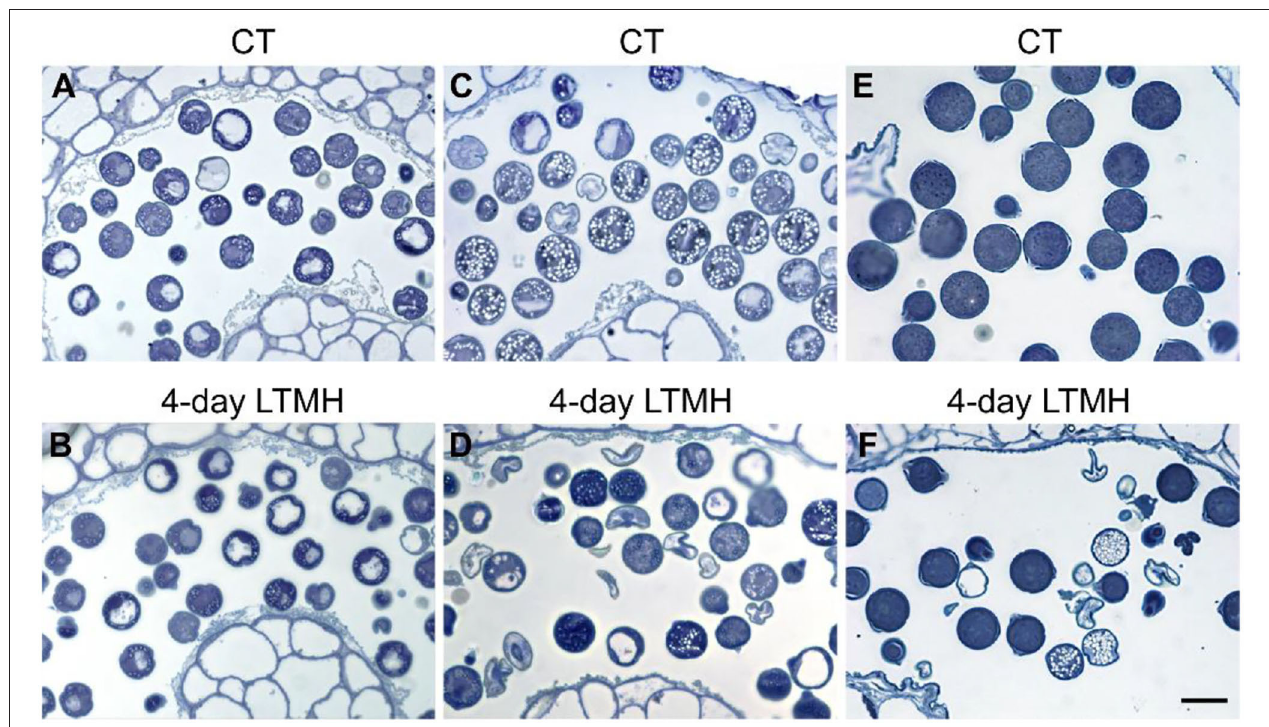
FIGURE 3 | Comparison of pollen cytology after control and 4-day long-term mild heat treatment by light microscopy. (A,B) Early bicellular pollen from control (CT) (A) and 4-day long-term mild heat treatment (LTMH) (B) . (C,D) Mature pollen from CT (C) and LTMH (D) . (E,F) Anthesis stage pollen from CT (E) and LTMH (F) . Bar = 20 µ